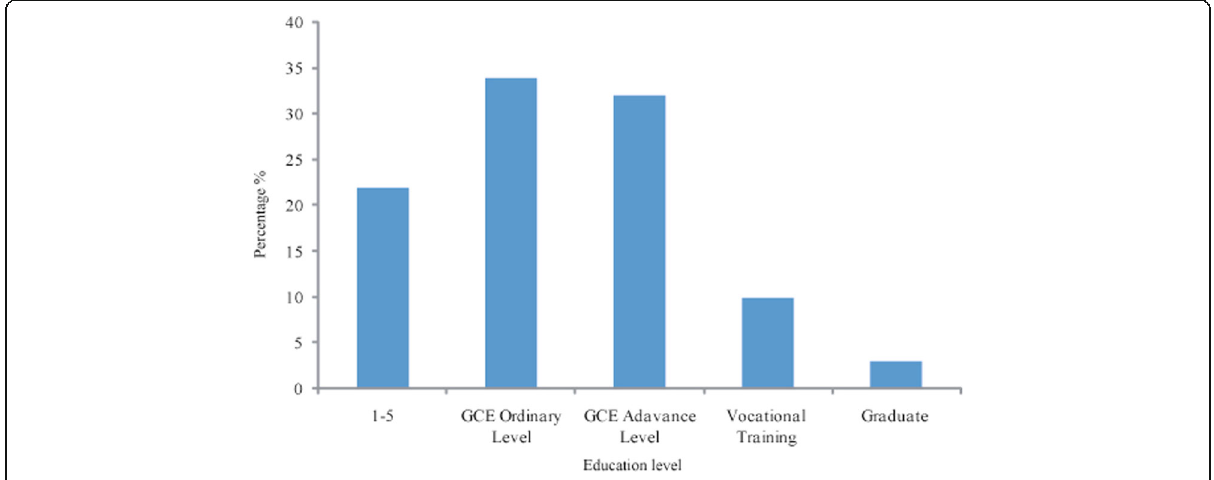
Fig. 6 Figure illustrates educational level in percentage wise in the